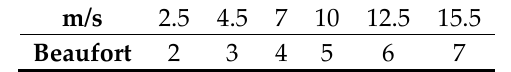
Table 1. Wind Speed in Beaufort scale and corresponding values in m/s.